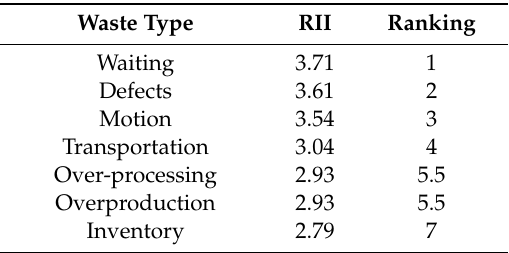
Table 4. Relative Importance Index (RII) and Ranking for waste